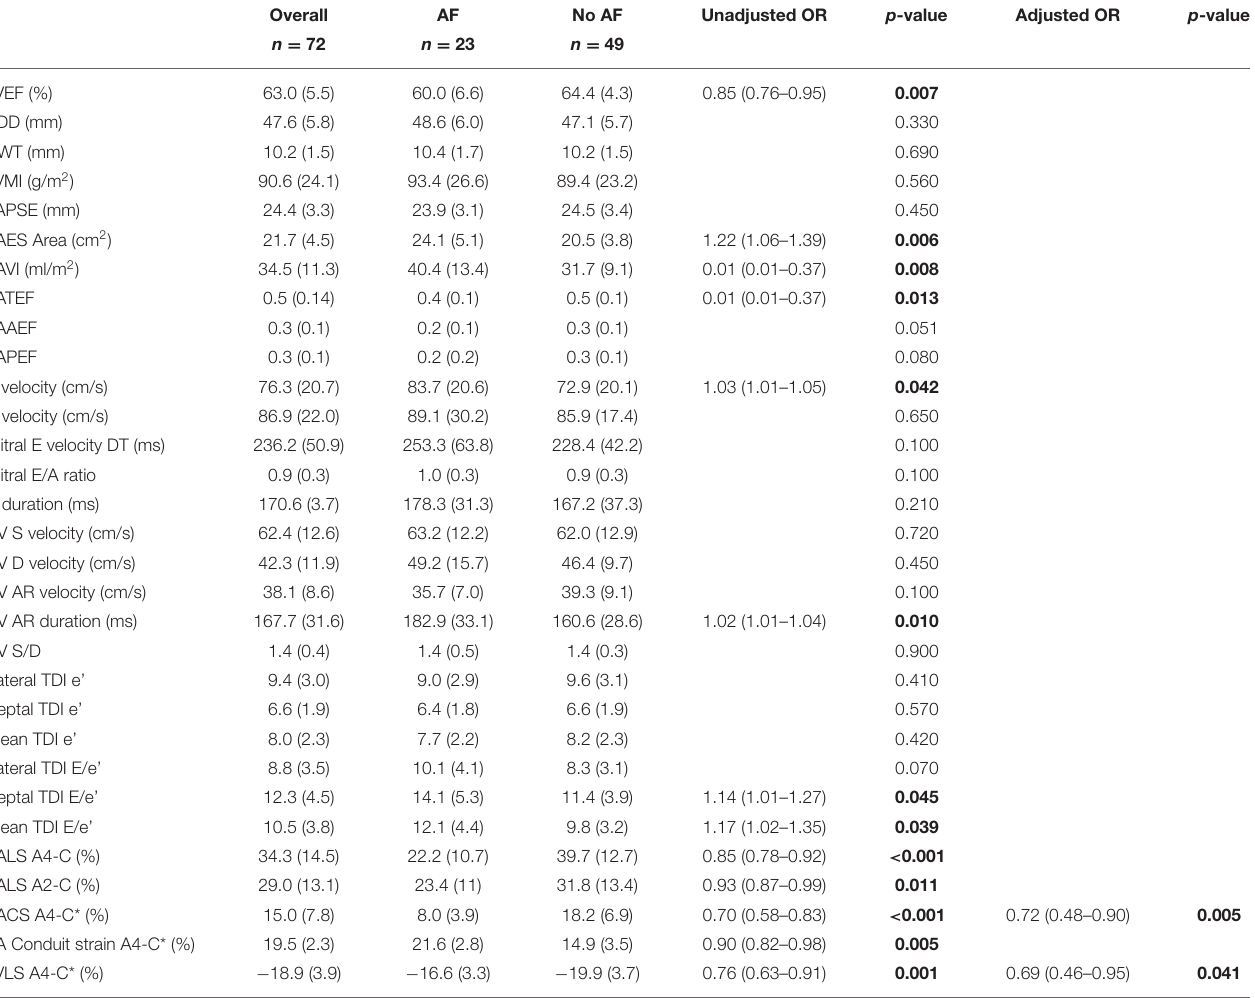
TABLE 3 | Echocardiographic parameters in the overall population and according to the occurrence of AF. Overall AF No AF Unadjusted OR p -value Adjusted OR p